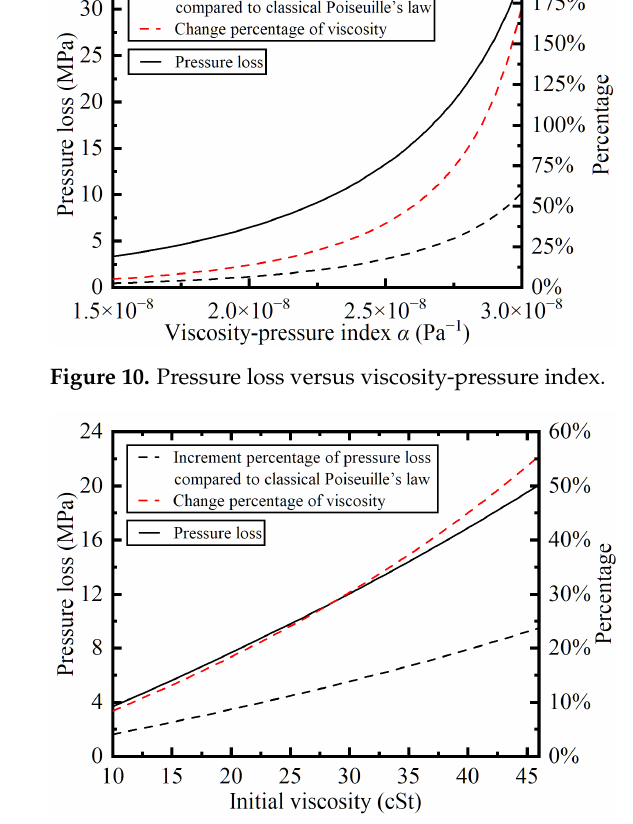
Figure 11. Pressure loss versus initial